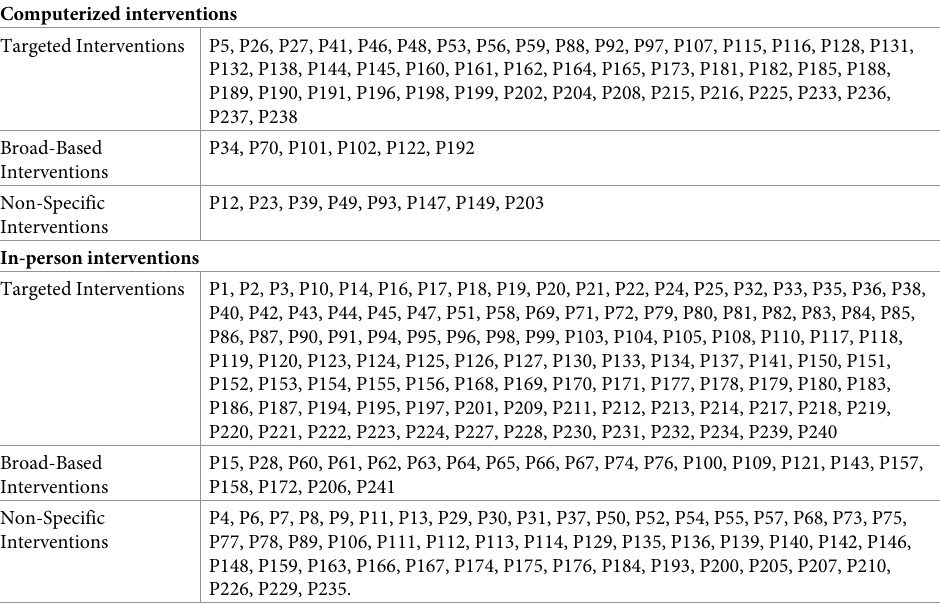
Table 6. Computerized vs. in-person